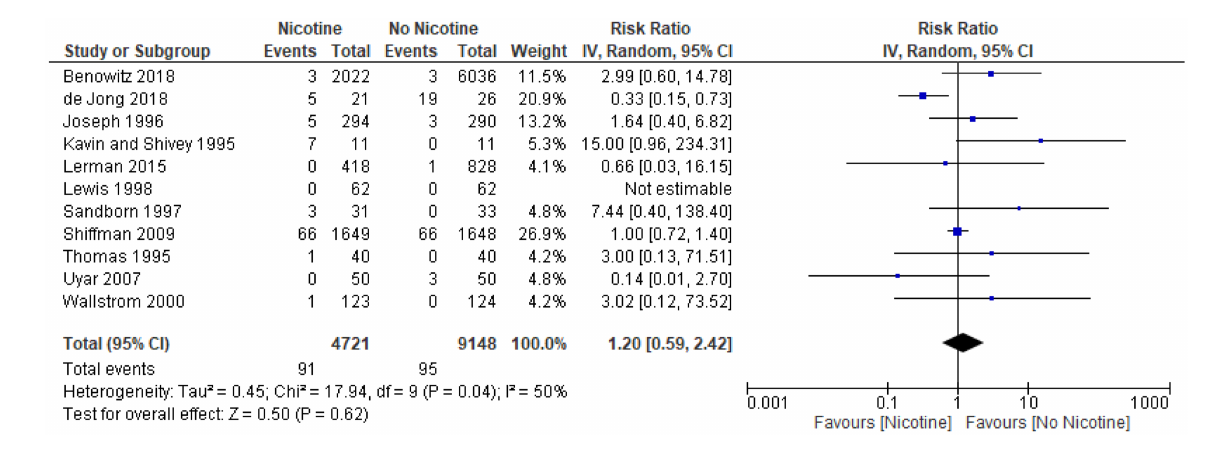
FIGURE 4 Forest plot, meta-analysis for arrhythmia